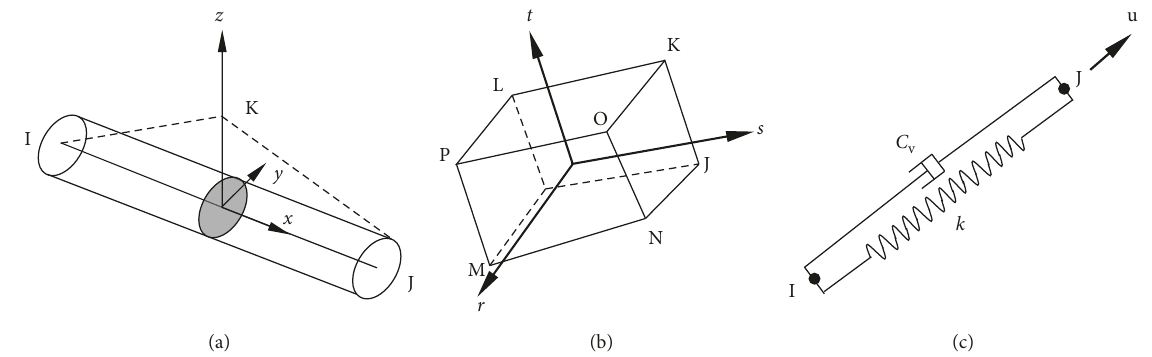
Figure 4: Track model. (a) Beam element. (b) Solid element. (c) Spring-damper element.